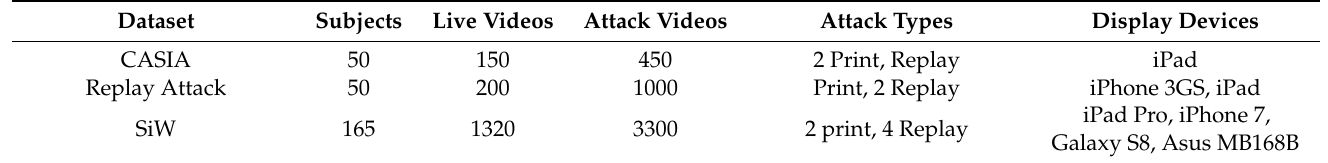
Table 1. Comparison of FAS datasets used in the evaluation of fusion method.